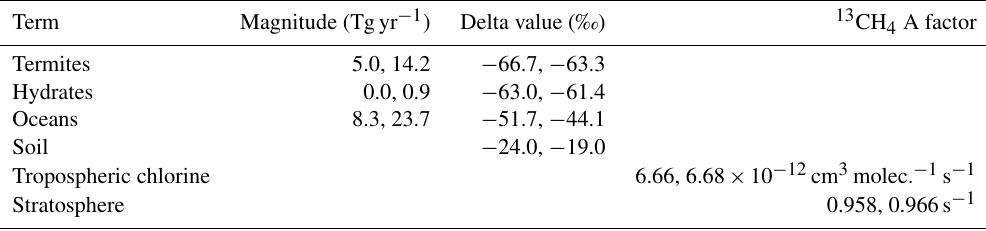
Table 3. The ranges of the invariant parameters explored (from the literature as in Sect. 2.2.2), where the first number is the minimum, and the second number is the maximum. The 13 CH 4 A factor is the Arrhenius pre-exponential factor, which is changed in the model to describe uncertainty in the kinetic isotope effect with respect to the losses. The OH and 13 CH 4 A factor was also considered, but MOZART only allows the rate constant to be input with two decimal places, and the OH and 13 CH 4 A factor is constant when given to two decimal places over the range of kinetic isotope effects